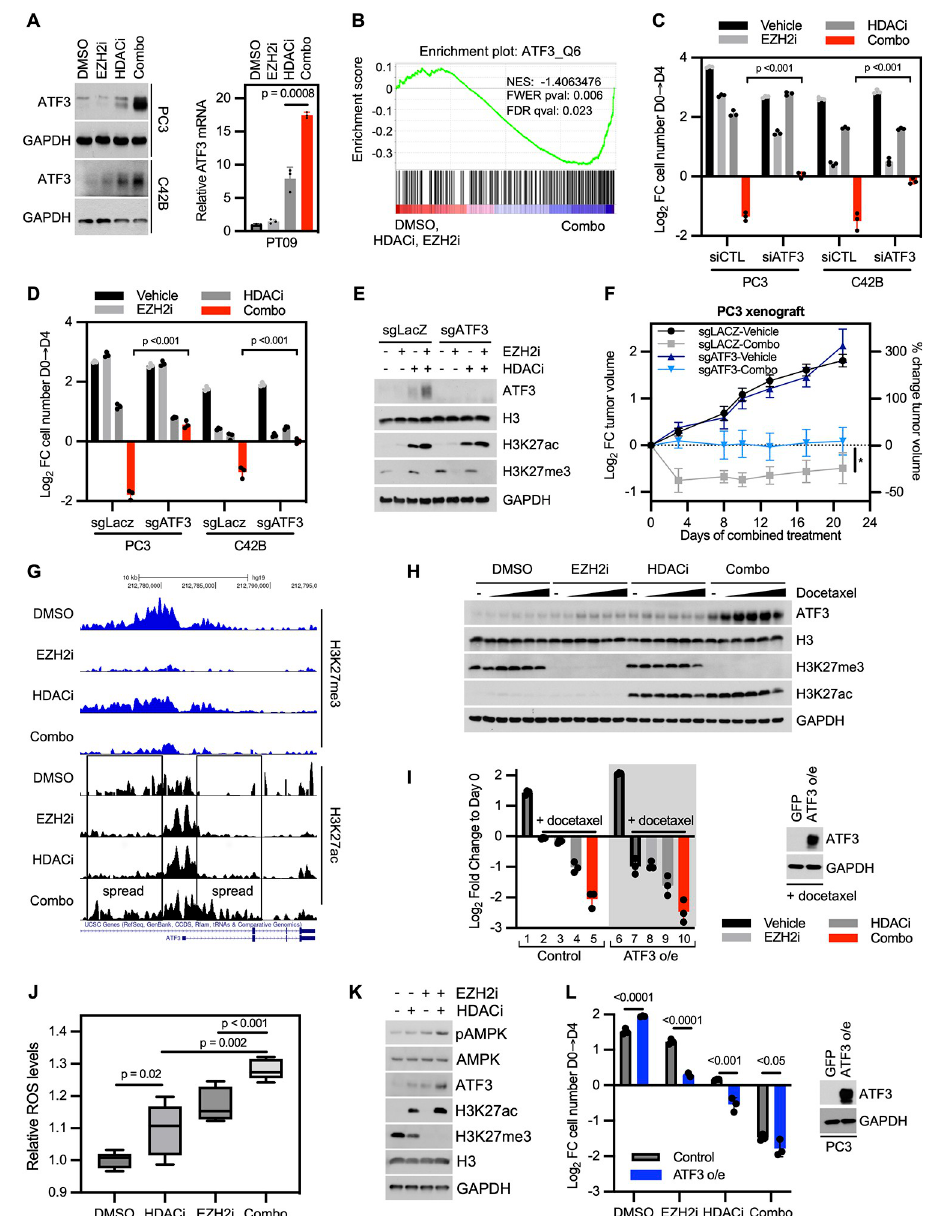
Fig 3. EZH2 and HDAC inhibitors kill CRPCs by up-regulating the common stress responsive transcription factor, ATF3. ( A) Expression of ATF3 in reponse to EZH2 and HDAC inhibitors. Prostate cancer cell lines treated with EZH2i and/or HDACi. Immunoblot of PC3 and C42B human cell lines (left) or RT-qPCR of PT-09 mouse cell line (right) with values normalized to GAPDH and fold change calculated in referenceto DMSO (S3Data).( B) GSEA of ATF3 transcriptional gene set (ATF3_Q6) comparing combo-treated PC3 cells to DMSO-, EZH2i-, or HDACi-treated cells. ( C) Graph depicting relative change in cell number of indicated cell lines transfected with siRNAs against a control sequence or ATF3 and then treated with vehicle, EZH2i, and/or HDACi (S3Data).( D) Graph depicting relative change in cell number of indicated cell lines stably transduced with sgRNAs against a control sequence or ATF3 and then treated with vehicle, EZH2i, and/or HDACi (S3Data).( E) Western blot of lysates from cells from ( D )probed with the indicated antibodies. ( F) Relative tumor growth curve of PC3 xenografts generated from cells described in (e) implanted subcutaneously in the flank of male castrated nude mice ( n = 7–10 per arm) (S3Data). P value is 0.015 and measured by two-way ANOVA test. ( G) Genome browser view of the ATF3 transcriptional start site. Tracks for H3K27me3 are shown in blue and H3K27acare shown in black. ( H) ATF3 immunoblots from PC3 cells treated with DMSO, EZH2i, HDACi, or the combination. Protein lysates were harvested after cells were additionally treated with increasing doses of docetaxel (0, 1, 2, 4, 8, 10 nM) for 24 hours. ( I )Bar graph of PC3 cells pretreated with EZH2i and then treated with HDACi